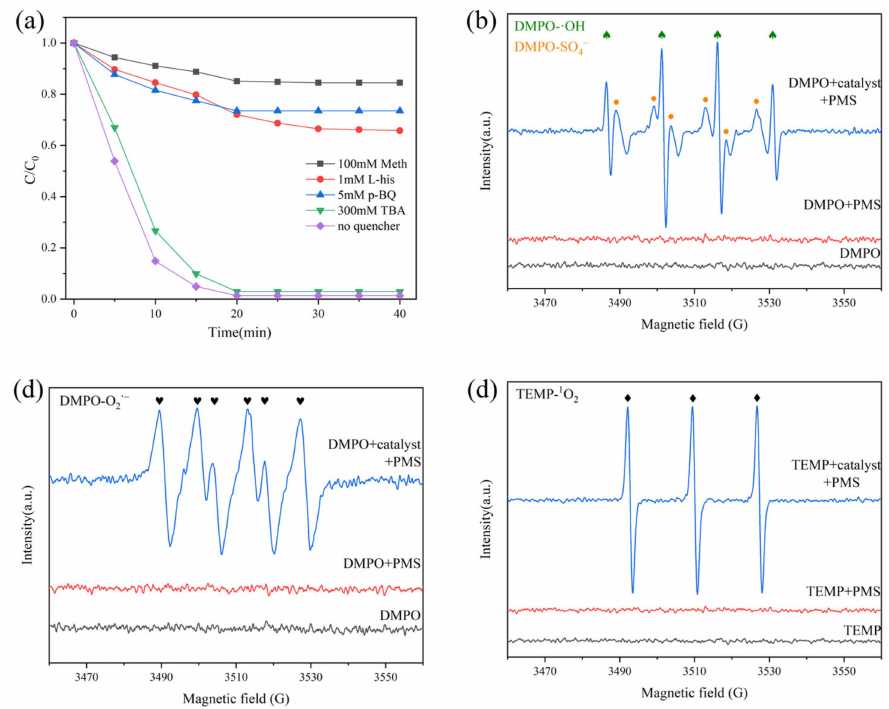
Figure 15. ( a ) Effect of radical scavengers on the degradation of CQP. EPR spectra in CoFe 2 O 4 @CNTs/PMS and PMS systems with DMPO ( b , c ) and TEMP ( d ) as the trapping agent. (Ex- perimental conditions: [[CQP] 0 = 10 mg/L, catalyst = 35 mg/L, PMS = 2.0 mM, initial pH = 6.5 ± 0.3, T = 25 ◦